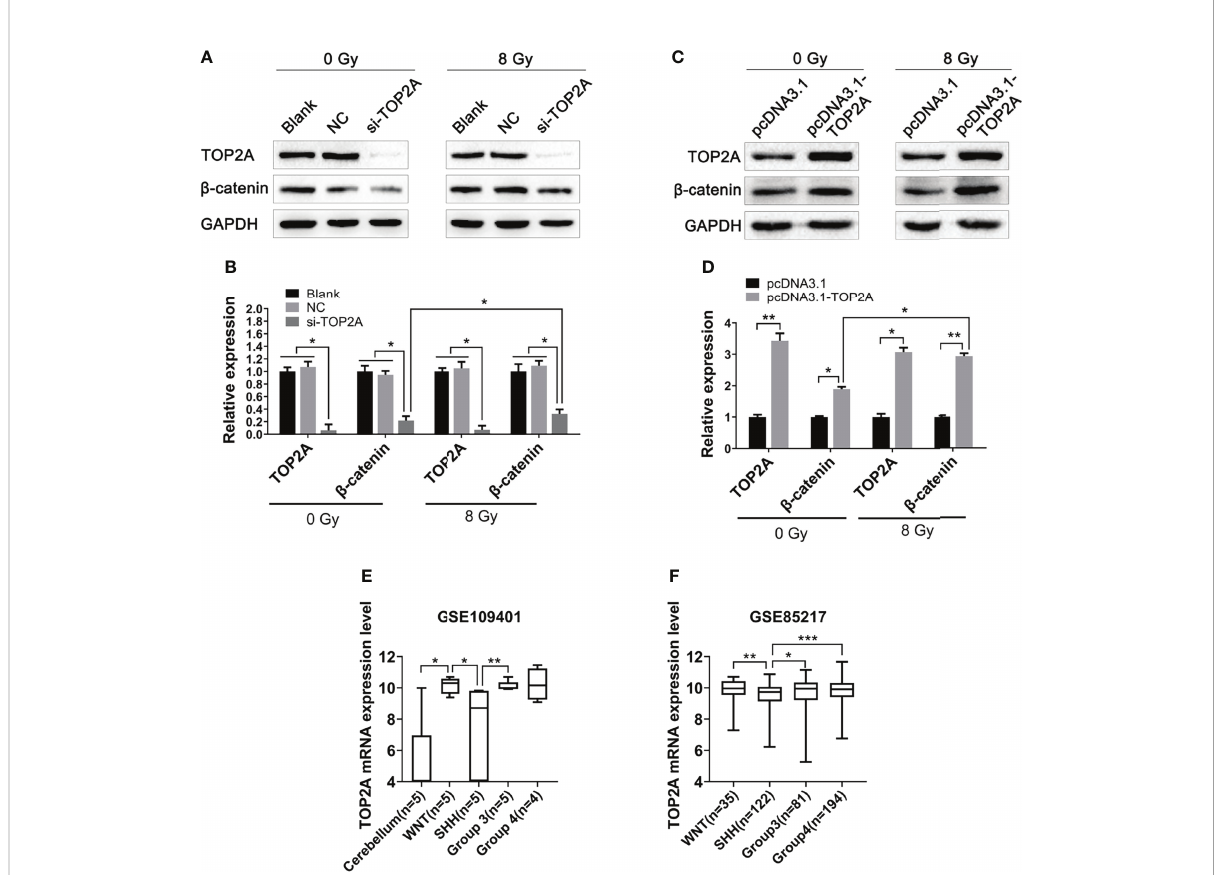
FIGURE 8 Downregulation of TOP2A inhibits the activity of the Wnt/ b -catenin signaling pathway. (A) Western blot assay was used to detect the expression of b - catenin following TOP2A knockdown alone or combined treated with 8 Gy IR. (B) Semi-quantitative densitometric analysis was used to measure the relative levels of TOP2A and b -catenin following TOP2A knockdown alone or combined treated with 8 Gy IR. *P<0.05. (C) Western blot assay was used to detect the expression of b -catenin following TOP2A overexpression alone or combined treated with 8 Gy IR. (D) Semi-quantitative densitometric analysis was used to measure the relative levels of TOP2A and b -catenin following TOP2A overexpression alone or combined treated with 8 Gy IR. *P<0.05, **P<0.01. (E) The expression of TOP2A in cerebellum tissues and MB molecular subgroups was analyzed in GSE109401. *P<0.05, **P<0.01. (F) The expression of TOP2A in MB molecular subgroups was analyzed in GSE85217. **P<0.01,